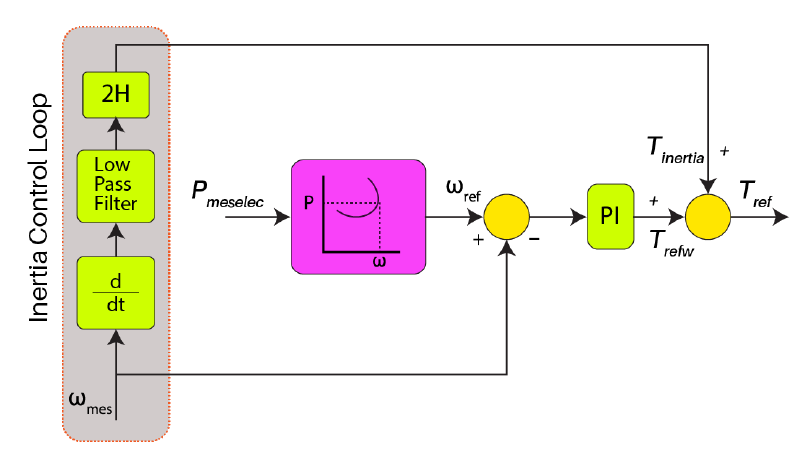
Figure 9. One-loop inertia